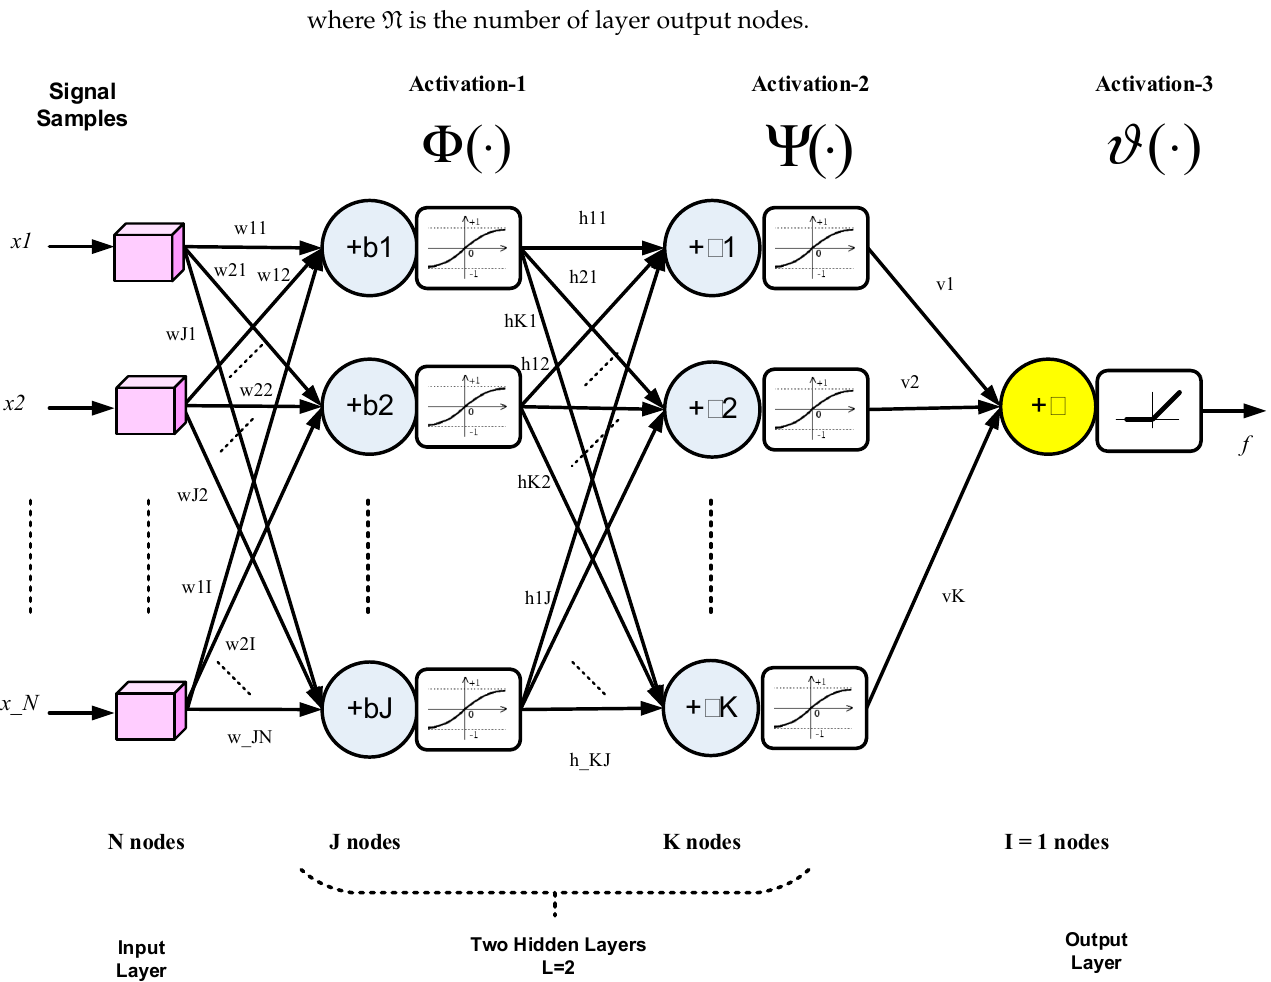
Figure 1. Structure of two-layer network for deep-learning (DL)-based frequency estimation (FE). Tanh activation for hidden layers is used to prevent results from expanding in mag- nitude and normalizing them in the [ − 1, 1] range. Both positive and negative values are needed for the proper adjustment of the network, unlike the case in the output layer, (ReLU) to give a proportional value to the input frequency as follows.